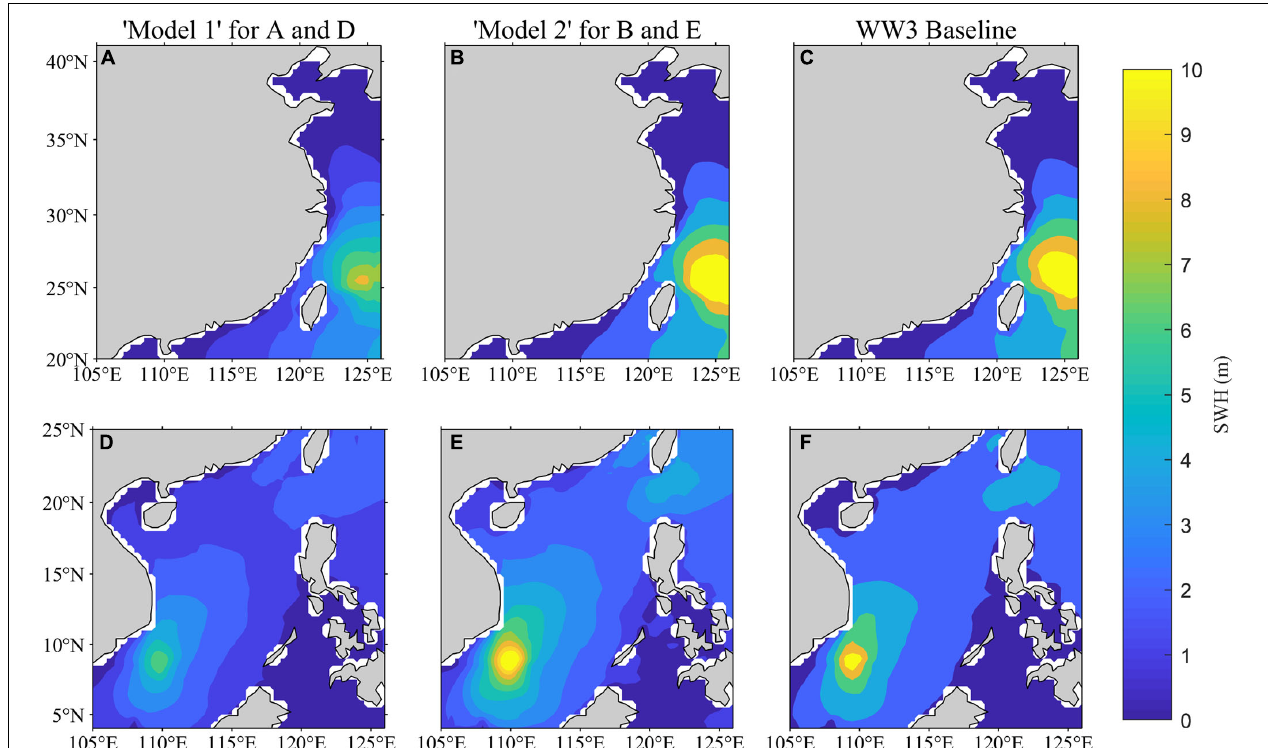
FIGURE 5 | The SWH prediction results of Model 1 and Model 2 under typhoon conditions in the East China Sea and South China Sea. (A–C) SWH of Typhoon “Lekima” over the East China Sea at 18:00 on August 8, 2019. (D–F) SWH of Typhoon “Tembin” over the South China Sea at 21:00 on December 24, 2017.